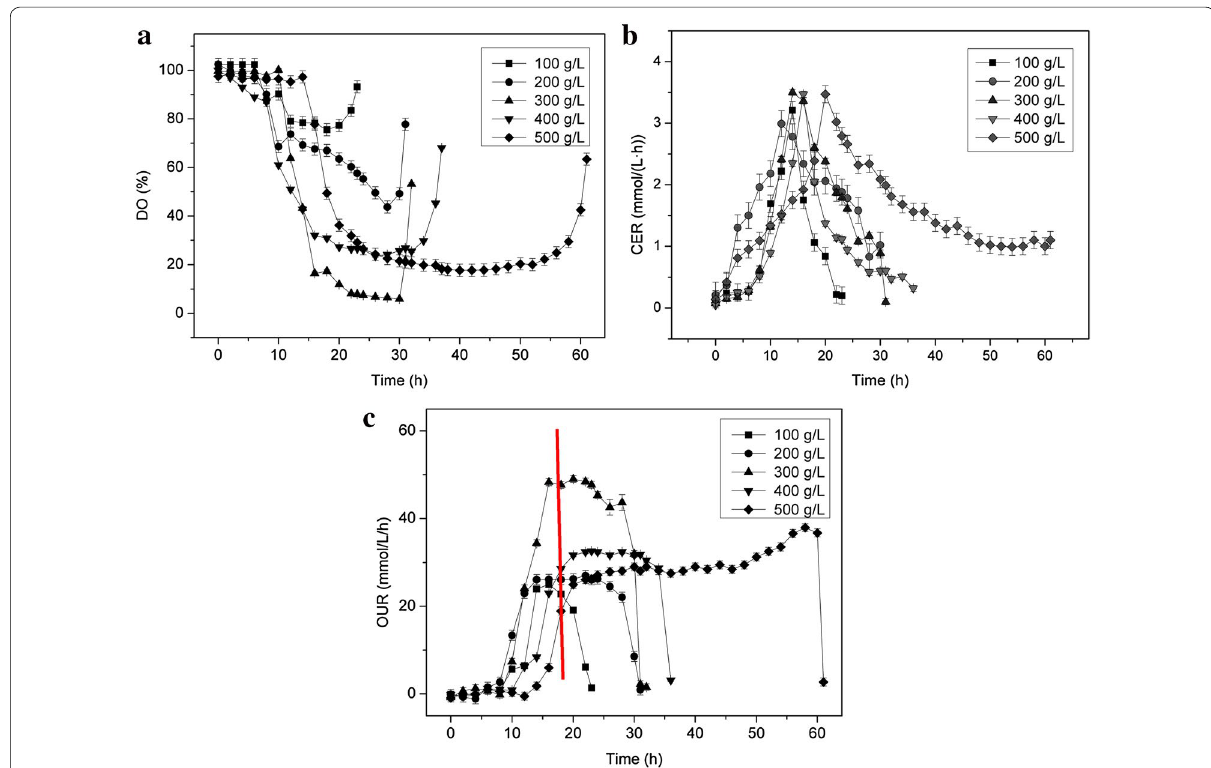
Fig. 5 Effects of different initial glucose concentrations on DO ( a ), CER ( b ), and OUR ( c ) evolutions in seed culture of A.